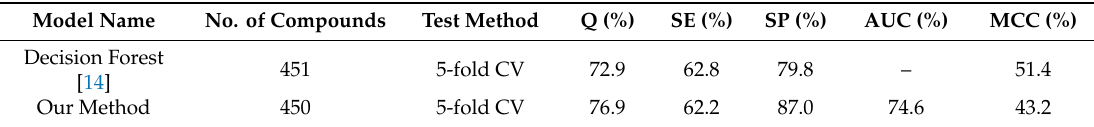
Table 5. Performance Comparison of Previous